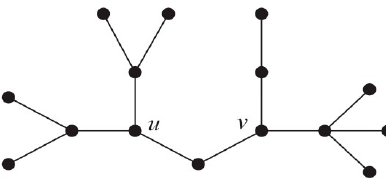
Figure 9. Two vertices with the same total distance which are not H -equivalent.